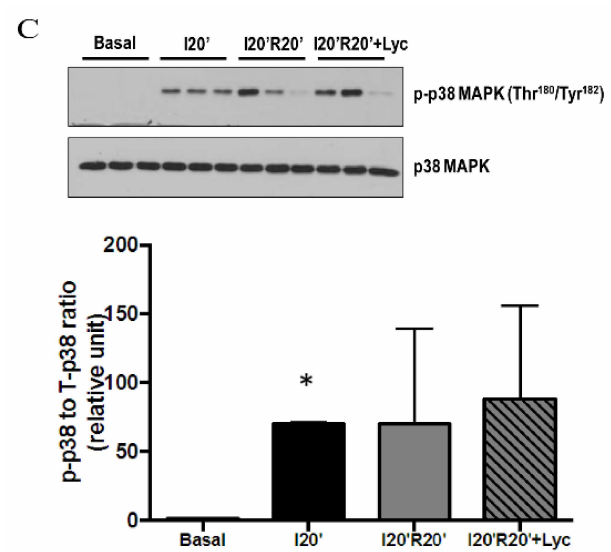
Figure 6. Effects of acute lycopene (Lyc) administration on MAPK signaling pathways during in vivo I/R: ( A ) lycopene administration significantly attenuated JNK phosphorylation at Thr 183 /Tyr 185 during reperfusion, * p < 0.01 vs. basal and I20 1 , † p < 0.05 vs. I20 1 R20 1 vehicle; ( B ) lycopene reduced p42/44 phosphorylation at Thr 202 /Tyr 204 during reperfusion, * p < 0.01 vs. basal, p = 0.07 vs. I20 1 R20 1 vehicle; and ( C ) lycopene has no impact on p38 phosphorylation during reperfusion, * p < 0.01 vs. basal.